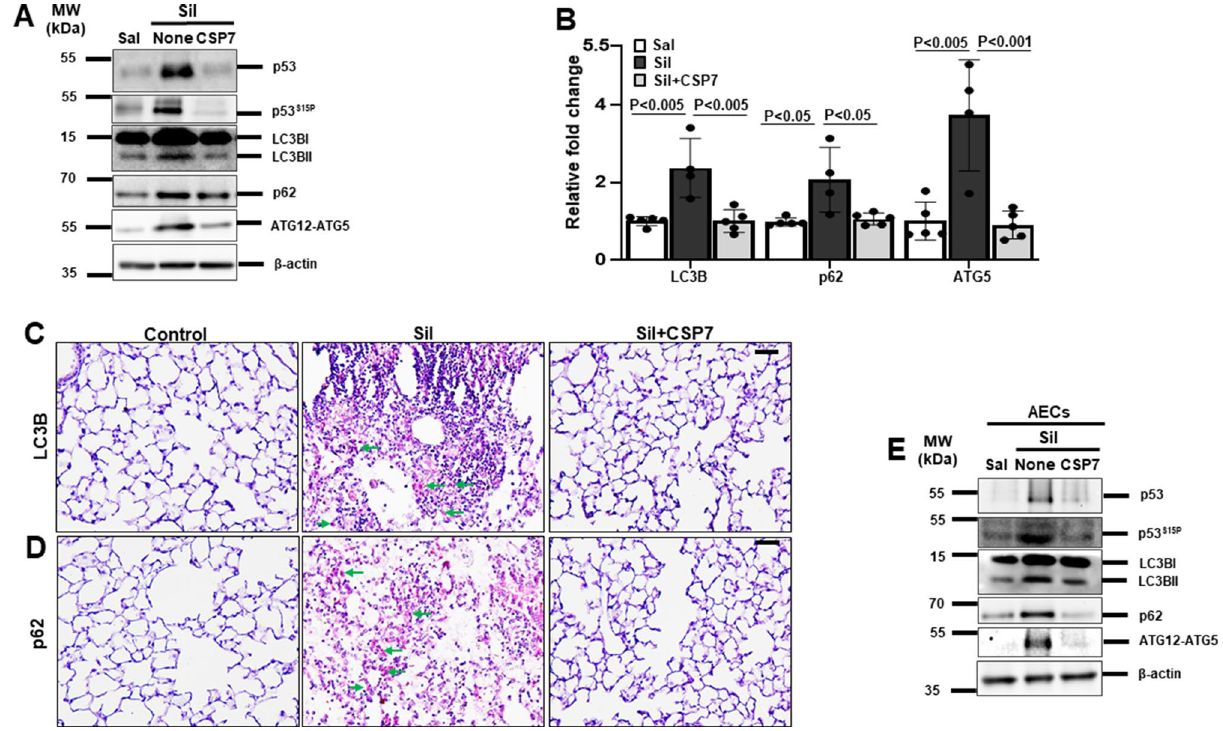
Figure 2. Abrogation of aberrant autophagy by CSP7 in mice with silica-induced PF. ( A ) Representative Western blot images showing the expression of p53, p53 phosphorylation at serine 15 residue (p53 S15P ), lipidated LC3B (LC3BII), p62 and ATG12-ATG5 complex in lung homogenates of naïve WT mice, and WT mice (n = 5–7) with silica-induced PF left untreated or treated with CSP7 as described in Fig. 1A. β-actin serves as loading control. MW: Molecular weight. kDa: Kilodalton. ( B ) Bar graph showing decreased LC3B, p62 and ATG5 mRNA in the lung homogenates of silica-exposed WT mice treated with CSP7. Representative immunohistochemistry images showing inhibition of ( C ) LC3B and ( D ) p62 expression by CSP7 in lungs of WT mice exposed to silica. Scale bar: 20 μm. ( E ) Representative immunoblot images showing inhibition of p53, p53 S15P , LC3BII, p62 and ATG12-ATG5 expression in AECs isolated from silica exposed WT mice treated with CSP7 in vivo . β-actin serves as loading control. MW: Molecular weight. kDa: Kilodalton. Each experiment was repeated at least 2–3 times and data is presented as mean + SD and p values were obtained by one-way Anova with Turkey’s multiple comparison test and log-rank tests,